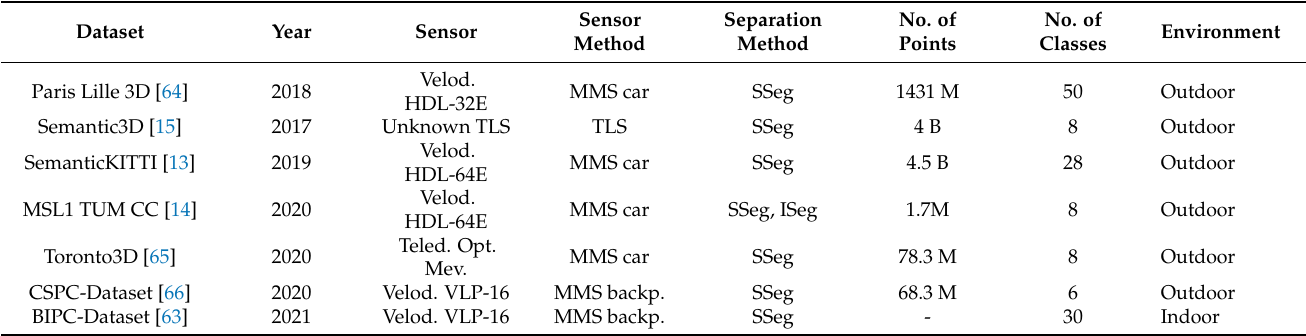
Table 3. LIDAR-recorded datasets with year of publication, sensor, sensor method, separation method (semantic segmentation (SSeg) and instance segmentation (ISeg)), number of points, number of classes and